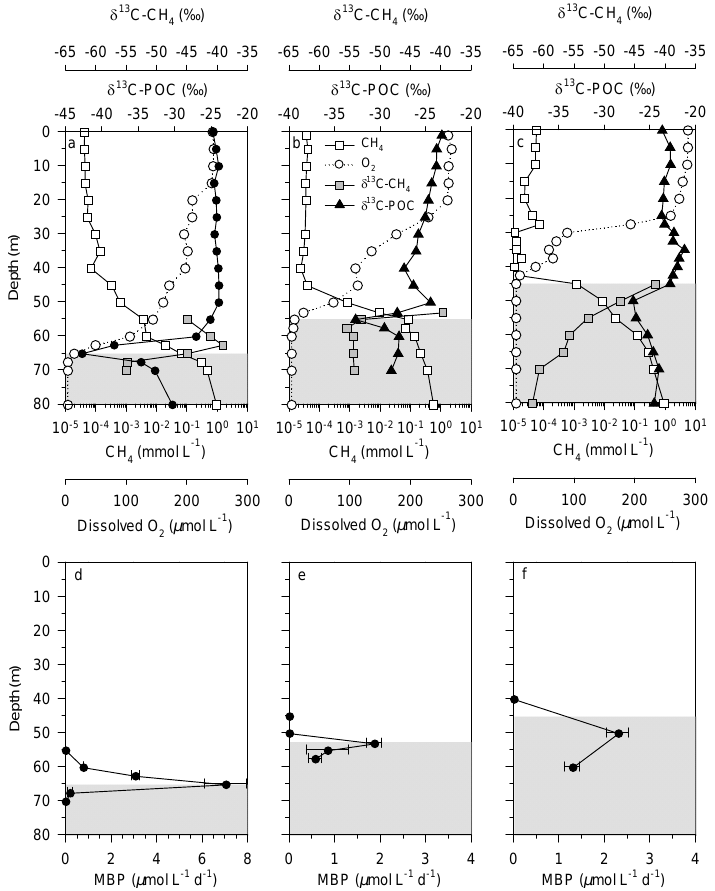
Figure 2. Vertical profiles of dissolved O 2 concentration (µmolL − 1 ) , CH 4 concentration (mmolL − 1 ) , δ 13 C-CH 4 (‰) and δ 13 C-POC (‰) in Lake Kivu, in September 2012 (dry season) in the southern basin (a) and northern basin (b) , and in February 2012 (rainy season) in the northern basin (c) . Information about the precision of measurement can be found in the material and methods section. Vertical profiles of methanotrophic bacterial production rates (MBP, µmolL − 1 d − 1 ) in September 2012 in the southern basin (d) and northern basin (e) and in February 2012 in the northern basin (f) . Symbols in (d) , (e) , and (f) represent mean values. Horizontal error bars represent standard deviation of replicates, when larger than the data point size. The grey zone corresponds to waters with dissolved O 2 concentration <3µmolL − 1